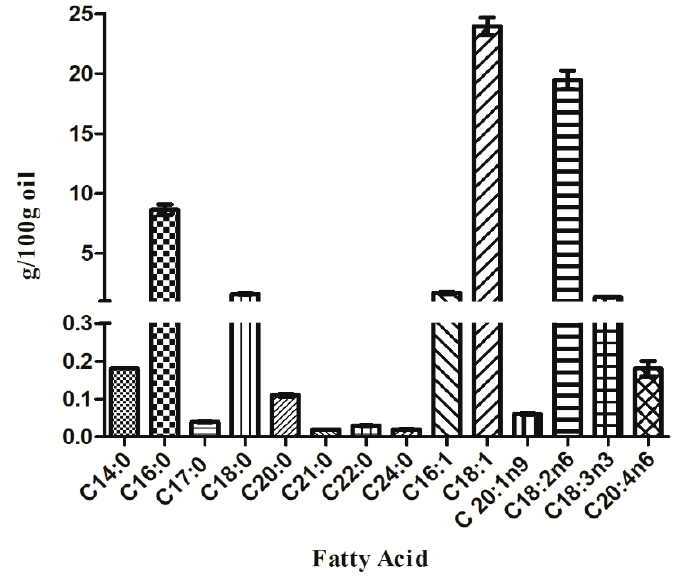
Table 2. Composition of the relevant groups of fatty acids and the nutritional qualities of Mayten tree seed oil.